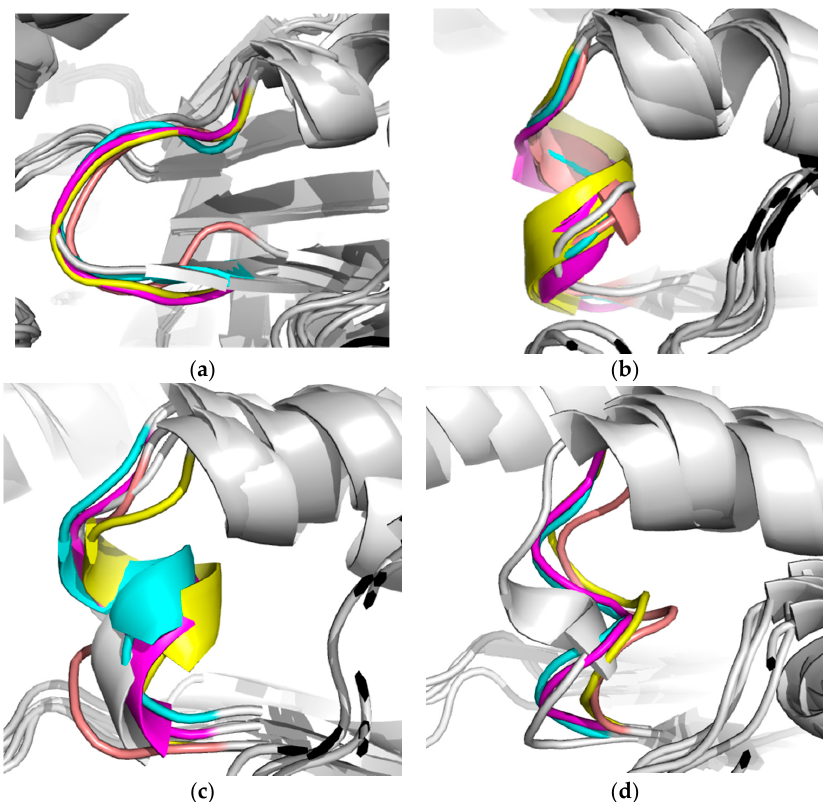
Figure 8. Loop 8 dynamics in ( a ) Apo-TbTIM; ( b ) TbTIM- 1 ; ( c ) TbTIM- 2 ; and ( d ) TbTIM- 3 . Cluster 1 (gray), Cluster 2 (cyan), Cluster 3 (magenta), Cluster 4 (yellow) and Cluster 5 (pink). The alignments were made based on backbone.